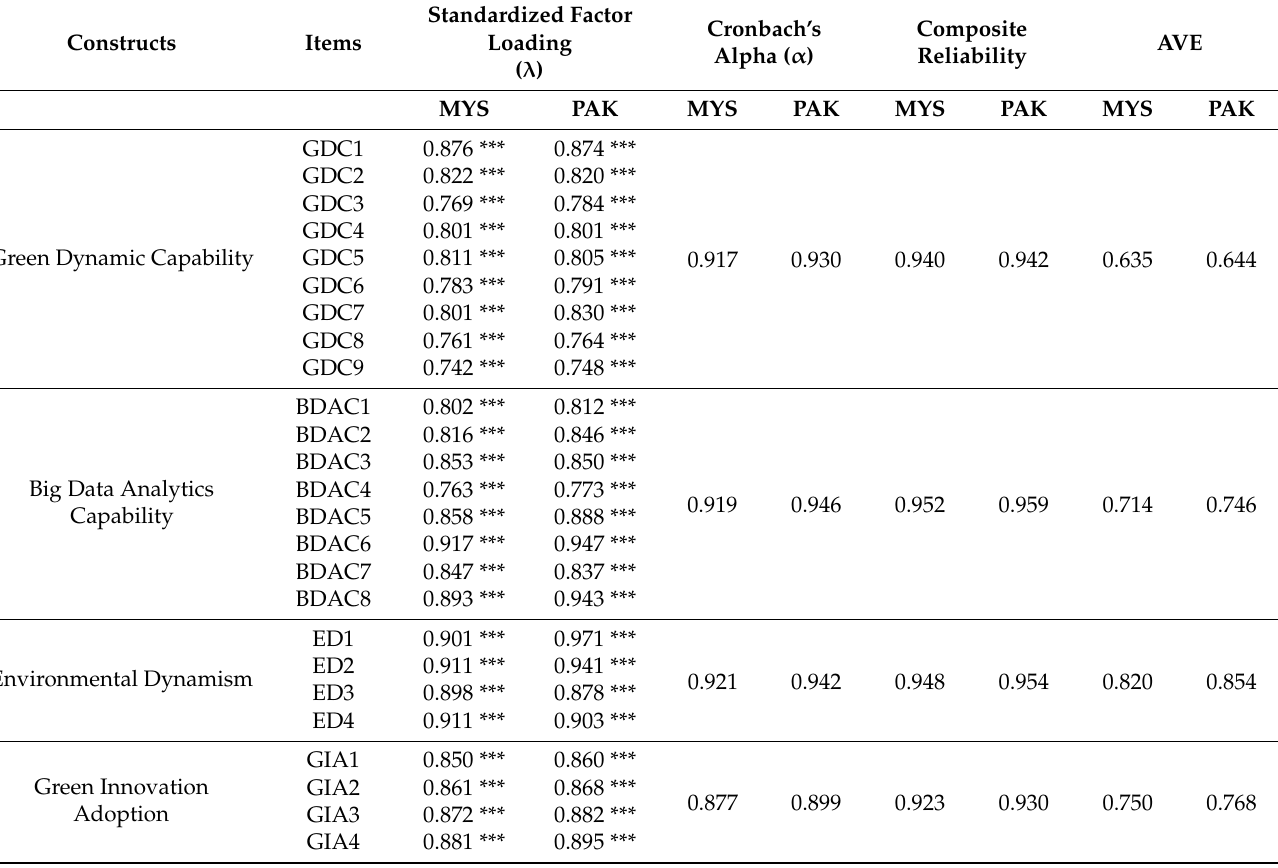
Table 4. Results of measurement model.